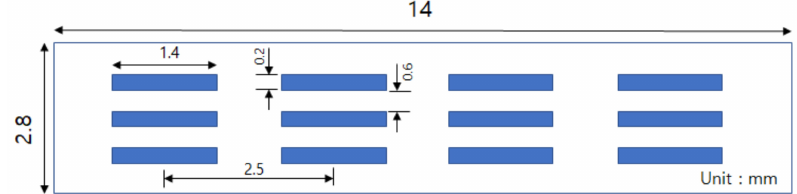
Figure 5. Layout and parameters for the designed director.